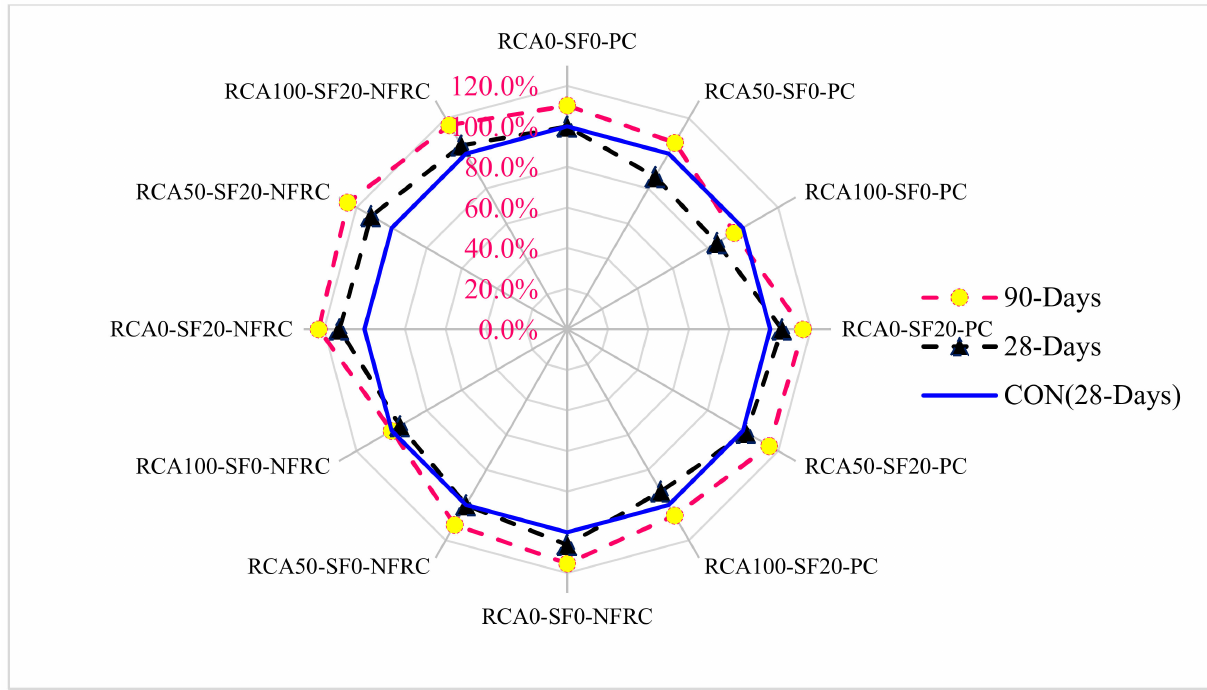
Figure 2. Relative Analysis of Compressive Strength.